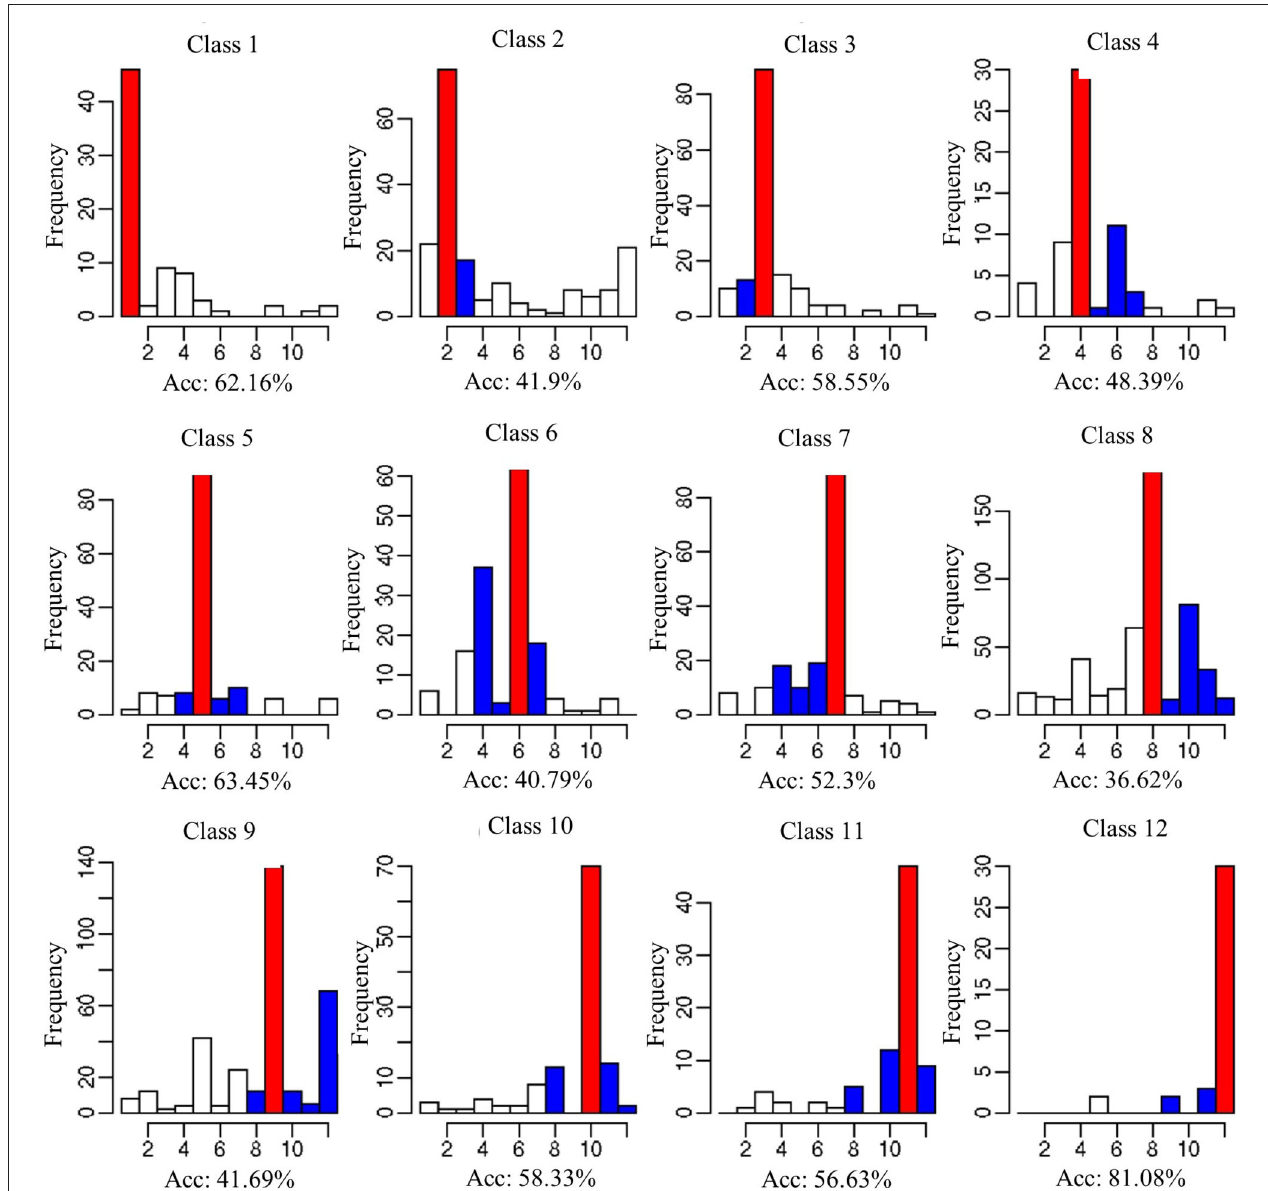
FIGURE 4 | RF prediction for each substrate class. The red bar represents each targeted class. The blue bins represent the classes lumped by silt (class 1), sand (classes 2 and 3), gravel (classes 4 ∼ 7), and cobble (classes 8 ∼ 12). The accuracy of each individual class prediction is listed for each subplot.